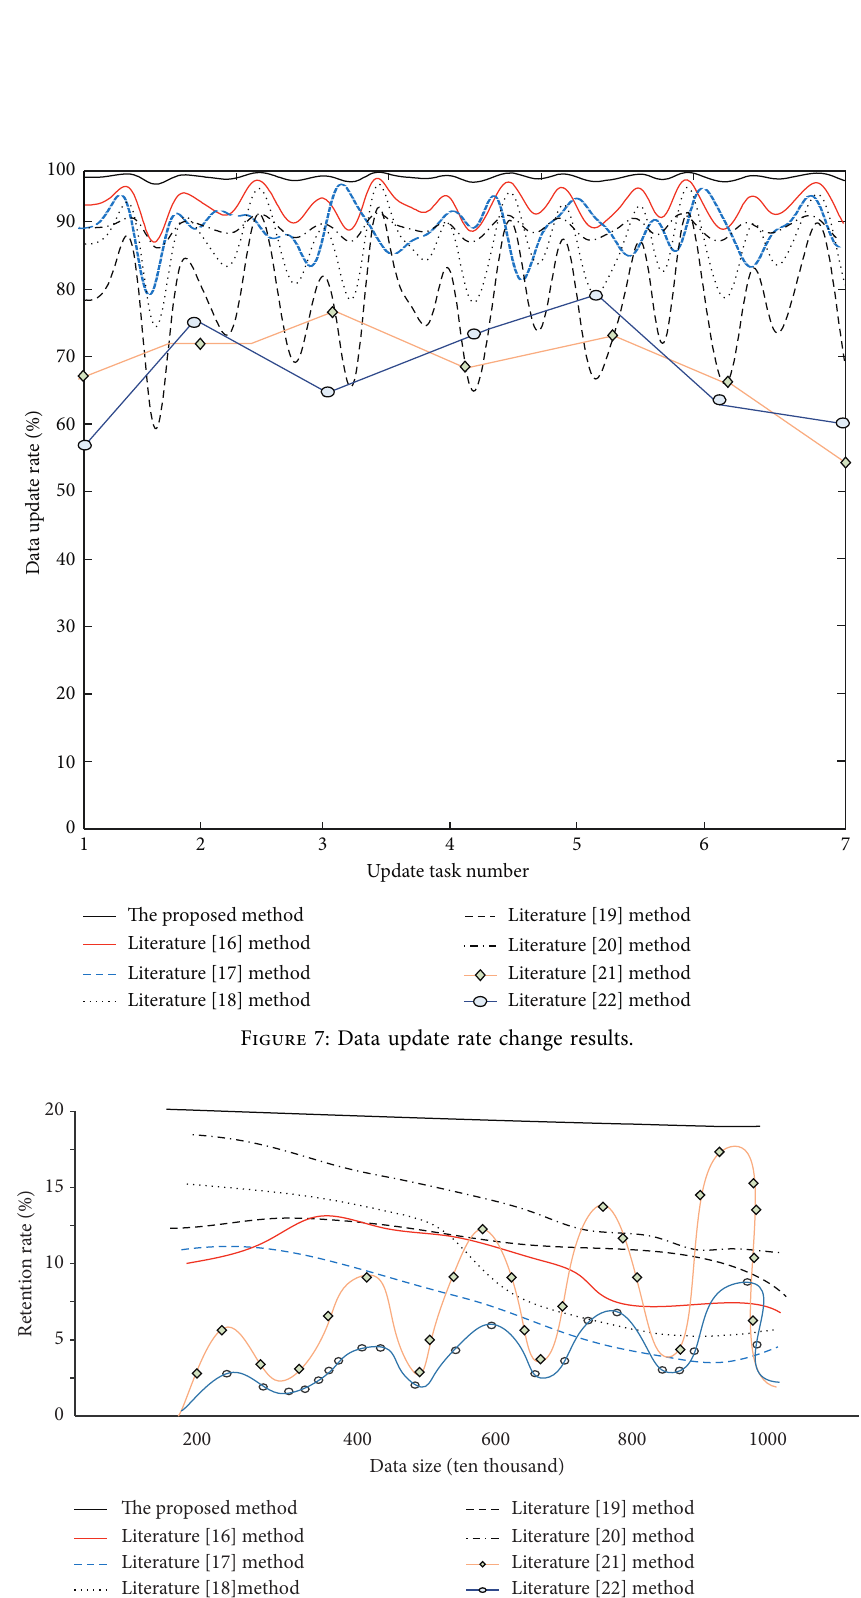
Figure 8: Change of retention rate of different